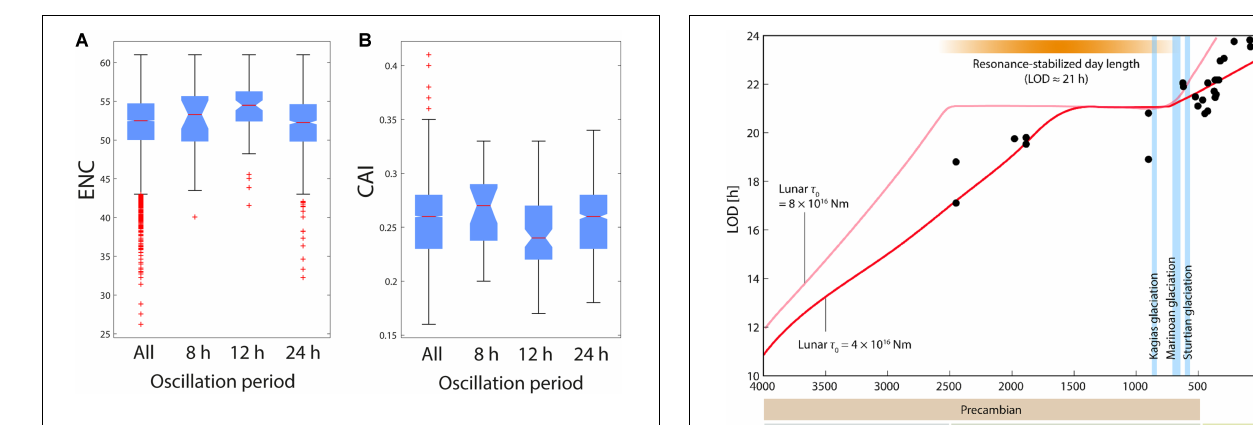
greatly overlap within comparative analyses, with five